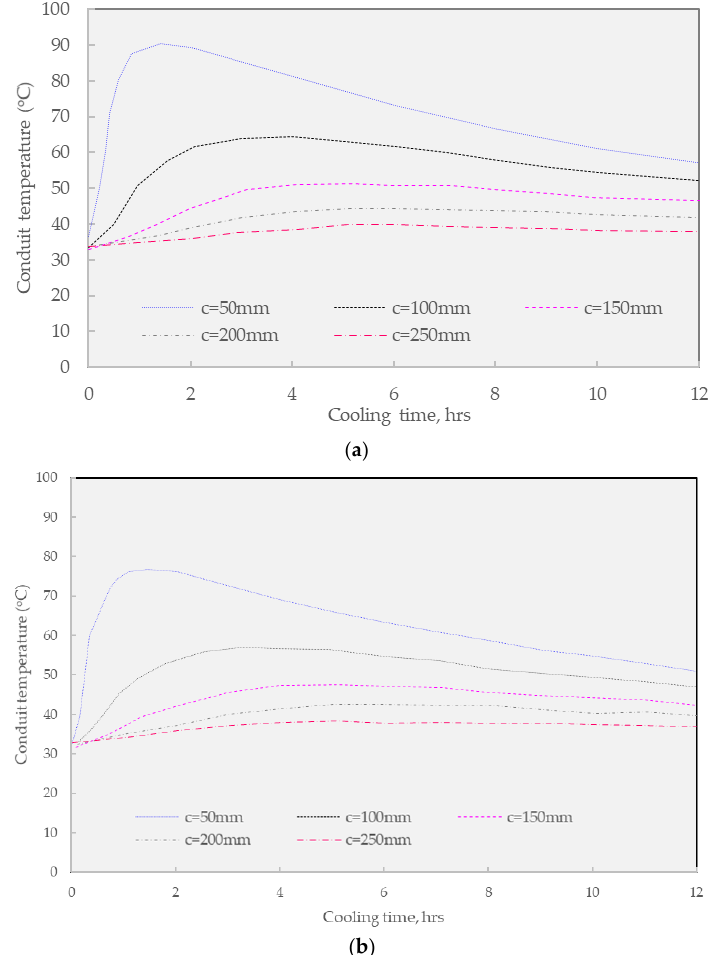
Figure 9. The temperature at the Top of the Conduit of FEA results. ( a ) Hot Mix Guss Mastic Asphalt; ( b ) Warm Mix Guss Mastic Asphalt.